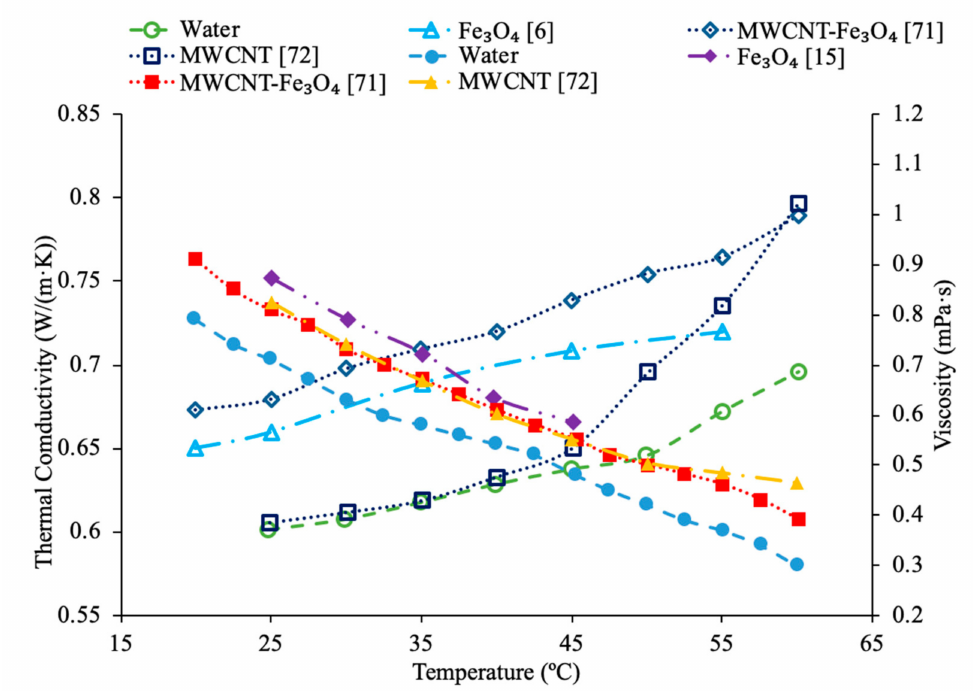
Figure 32. Thermal conductivity (increasing with temperature) and viscosity (decreasing with temperature) Fe 3 O 4 –MWCNT hybrid nanofluid, MWCNT and Fe 3 O 4 with water as a base fluid at a volume of 0.1%